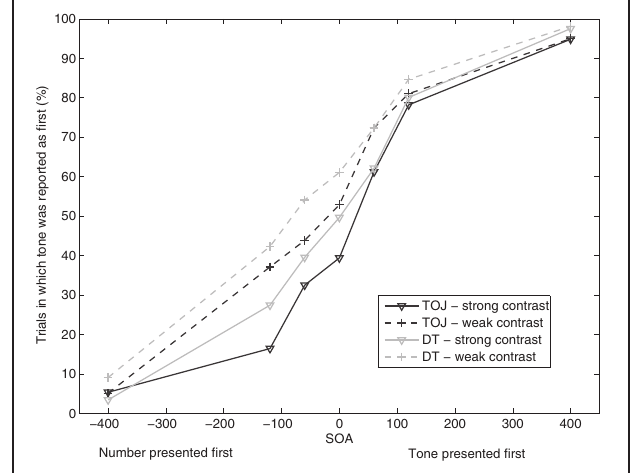
FIGURE 1 | Proportion of trials in which the participants reported the tone task as first in the conditions of temporal-order judgment (TOJ) and dual task (DT) in Experiment 1, each with two contrast conditions (strong and weak